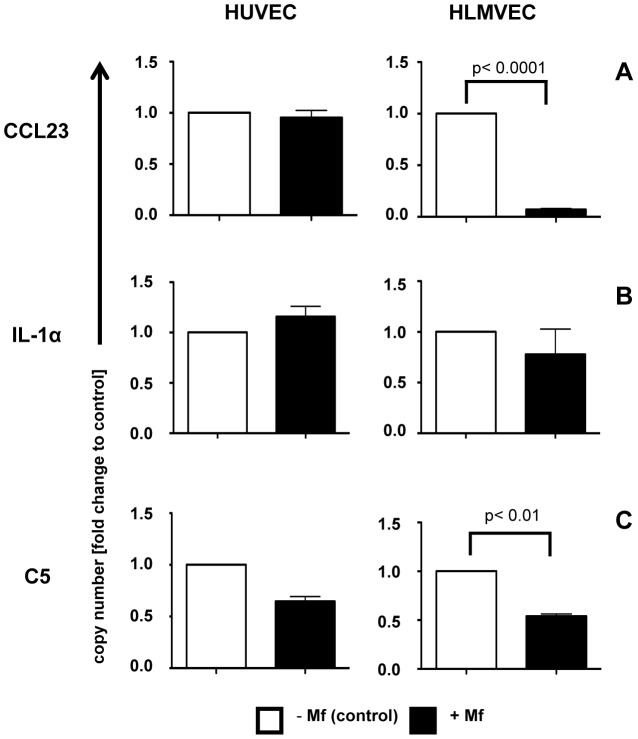
Live B. malayi Mf presence does not greatly alter gene expression of vascular EC pro-inflammatory mediators.HUVEC or HLMVEC were cultured with live B. malayi Mf for 24 hours prior to isolation of total EC RNA. Real time quantitative RT-PCR was used to analyse mRNA expression of (a) CCL23, (b) IL-1α and (c) C5. Data are shown as the mean and standard deviation per group of three independent experiments and p values were determined using the Student's t test.